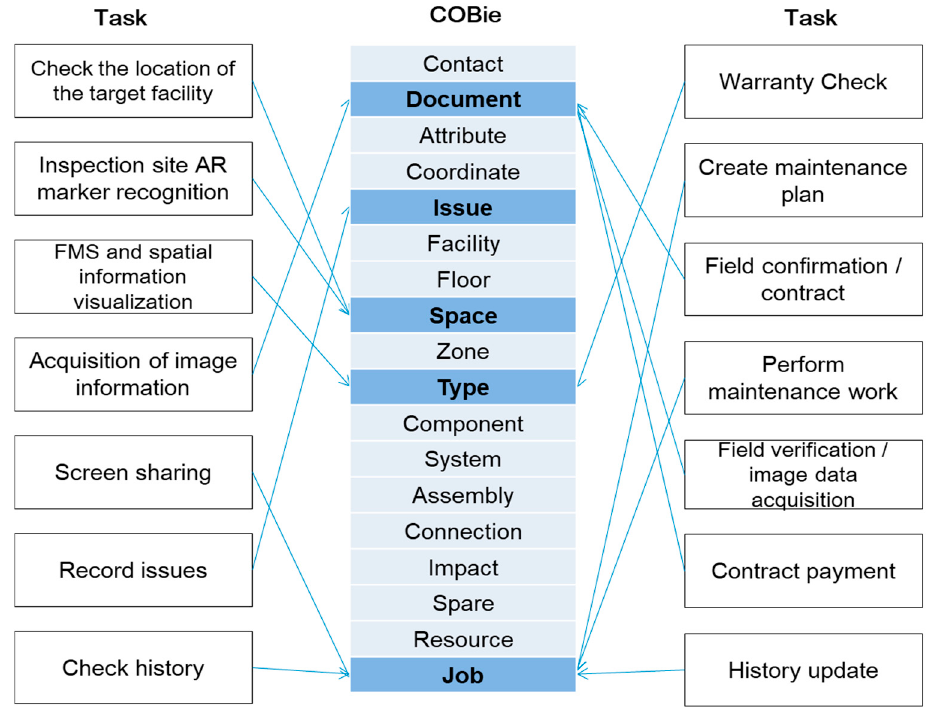
Figure 6. Detailed scenario COBie datasheet mapping for each task category. The mapping of task categories within an FM work requiring AR technology with the COBie datasheets showed that only five datasheets (i.e., Document, Issue, Space, Type and Job) included all the attribute data required for on-site FM work. For analysis of each datasheet, the ‘Document’ sheet includes image data acquired from the site, along with contract documents, 3D shape information, shop drawings, warranty documents and other documents, as shown in Figure A1. It consists of seven data fields: ‘Document Name’, ‘Doc- ument Type’, ‘Sheet Name’, ‘Row Name’, ‘Storage Location’, ‘File Name’ and ‘Description’. All of these data fields are not included in the BIM data at the time of handover and must be populated through additional work. The ‘Issue’ sheet has a dataset to record issue-specific items and is composed of six data fields, consisting of ‘Writer’, ‘Date of Writing’, ‘Issue Type’, ‘Space Name’, ‘Component Type’ and ‘Description’, as shown in Figure A2. The ‘Space’ sheet, which includes information such as the space name, building name, floor, ID for spatial identification and installed sensor information, automatically generates all this information through mapping with the BIM data (Figure A3). The ‘Space’ sheet data fields include ‘Description’, ‘Facility Name’, ‘Floor Name’, ‘Room Tag’ and ‘Sensor ID’. As shown in Figure A4, the ‘Type’ sheet includes five data fields: ‘Component Name’, ‘Space Name’, ‘Category’, ‘Manufacturer’ and ‘Warranty Description’. Each data field includes detailed information, such as the type of construction materials installed, their model names, manufacturers and warranty information, which is generated through interfacing with the BIM data. Finally, the ‘Job’ sheet contains the overall data on maintenance progress and completion, warranty period and history track record information (Figure A5). The data fields that make up the ‘Job’ sheet include ‘Job Name’, ‘Status’, ‘Start Date’, ‘Duration’, ‘Warranty Period’ and ‘Description’. The standard COBie datasheets consist of 277 data fields in 18 datasheets, but the COBie information exchange system proposed in our study consists of 29 data fields in 5